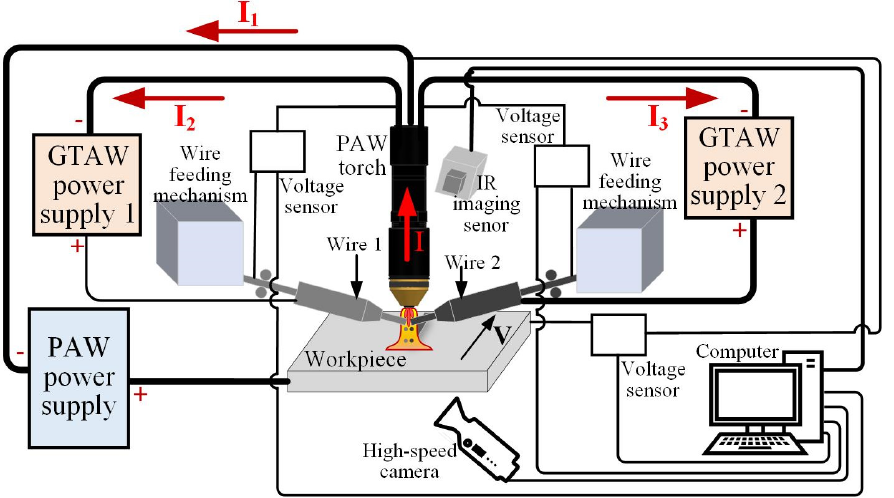
Figure 25. Schematic of double-wire bypass plasma arc AM.